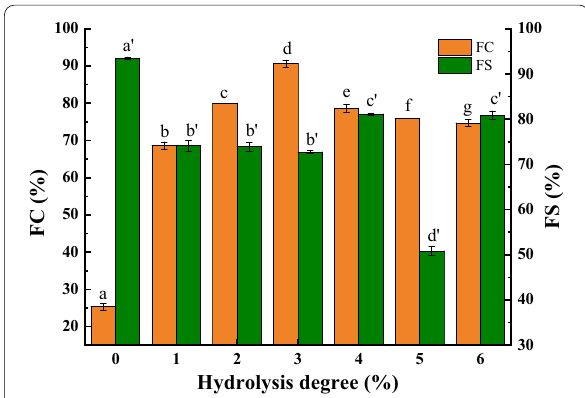
Fig. 7 Foaming properties of SPH at 0–6%DH, respectively. FC foaming capacity; FS foaming stability; values with different superscript letter are significantly different p < 0.05. a–g is used for FC and a ′ –d ′ is used for